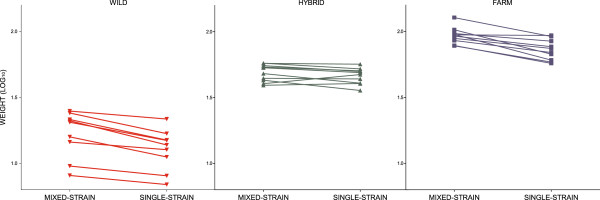
Growth reaction norms between the mixed-strain treatment and single-strain treatment, experiment I. Family weight (log10) norm of reaction between the two rearing treatments, for salmon of farmed, hybrid and wild salmon. Replicated tanks are pooled. Fish sizes were significantly higher in the mixed-strain treatment than in the single-strain treatment, and the elevation of the reaction norms were significantly different between salmon of farmed, hybrid and wild origin. The slopes between treatments were similar in the wild and farmed salmon, while the flatter slopes displayed by the hybrid salmon were significantly different to the slopes displayed by both the farmed and wild salmon. A significant correlation between mean family weight in the mixed-strain treatment and mean family weight in the single-strains treatment were detected in salmon of all origin.